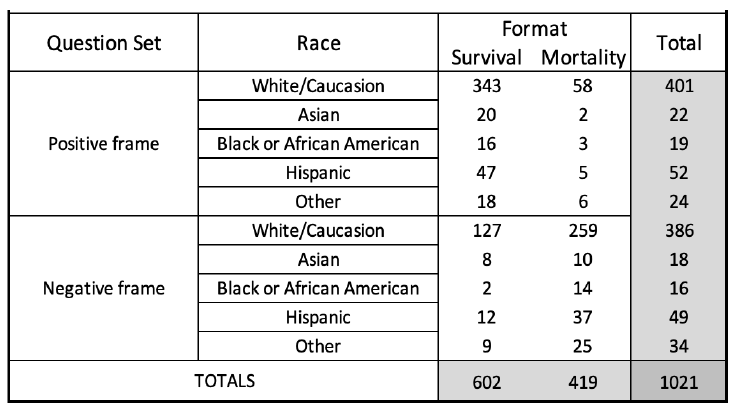
Figure 4: Respondent Totals by Race.